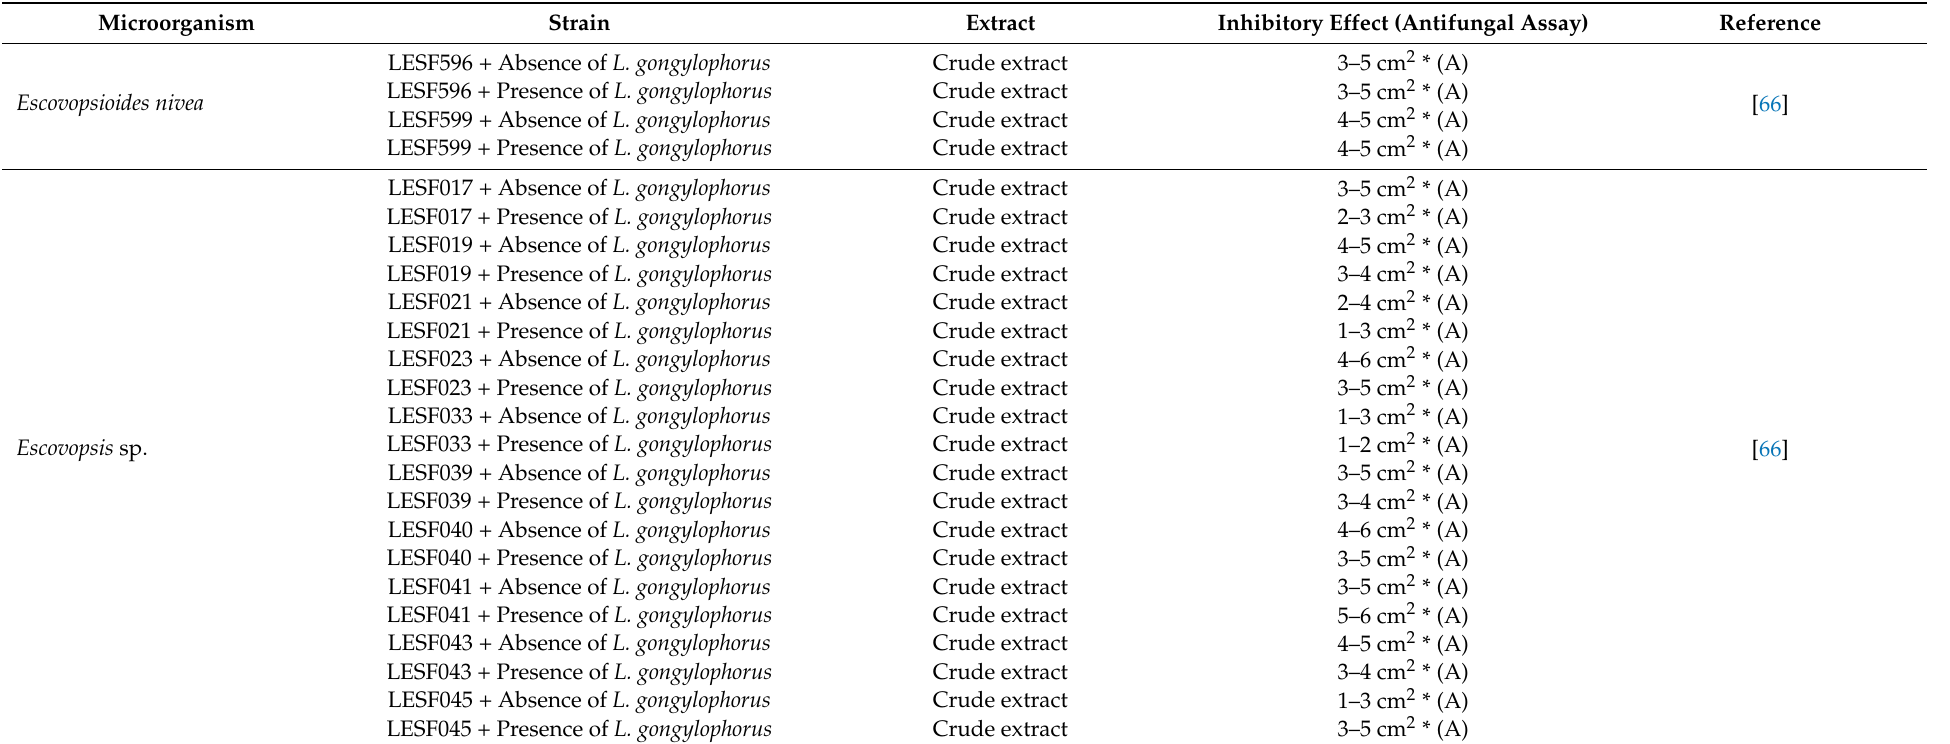
Table 2. Microorganisms extracts with potential antifungal effects against Leucoagaricus gongylophorus by in vitro assays.